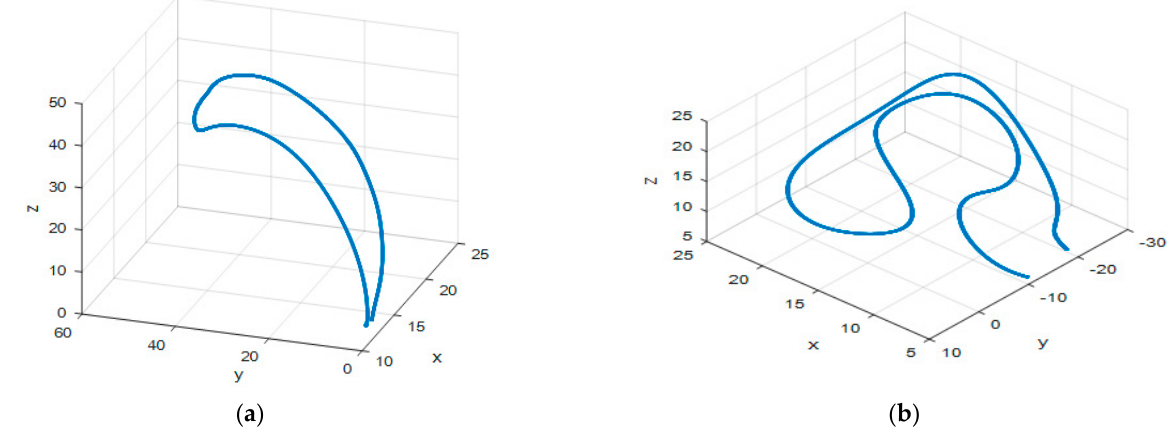
Figure 3. 3 ‐ D hand trajectories for the designed types of tasks that were drawn from the sample of the experiment. ( a ) Pick up a bottle from the table and pour it into a cup (Task_1); ( b ) manipulation tasks with multiple obstacles (Task_2).